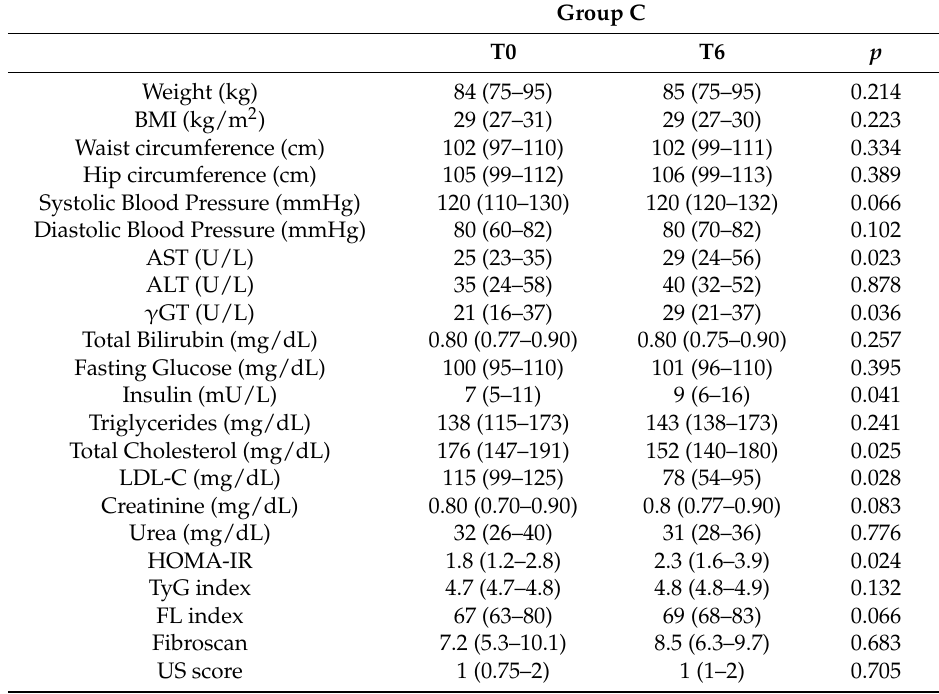
Table 4. Comparison of anthropometric, biochemical and clinical features at baseline (T0) and after six months (T6) in control patients (Group